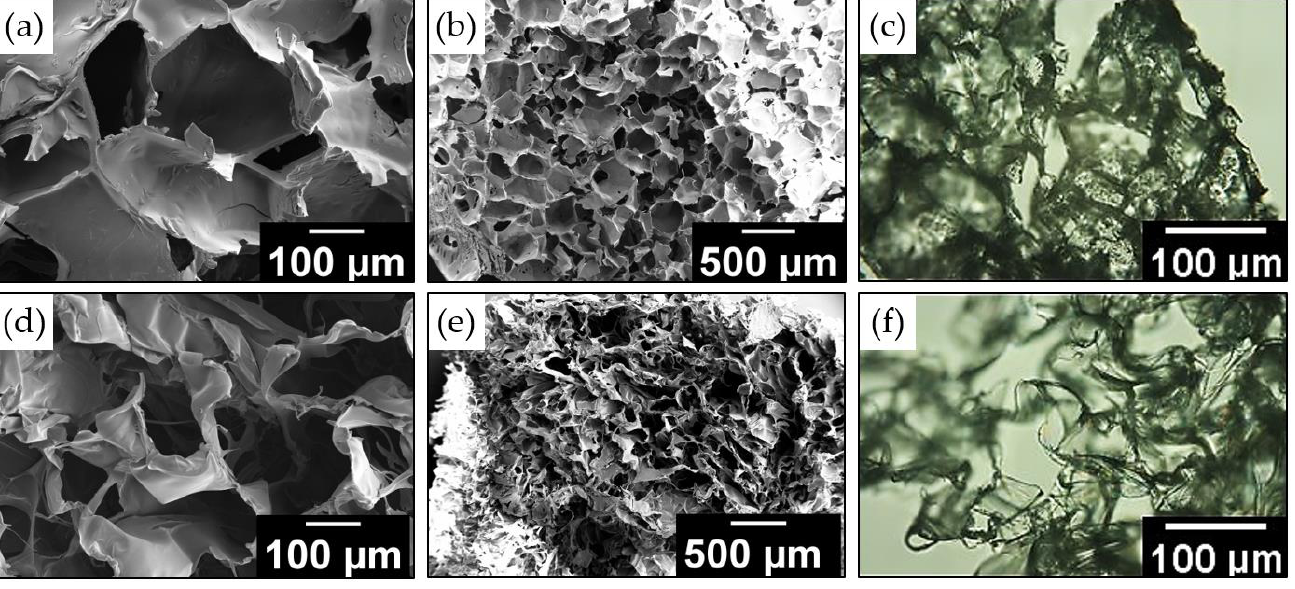
Figure 4. SEM ( a , b , d , e ) and optical microscopy ( c , f ) images of the cryogel sample 2 before ( a – c ) and after swelling ( d – f